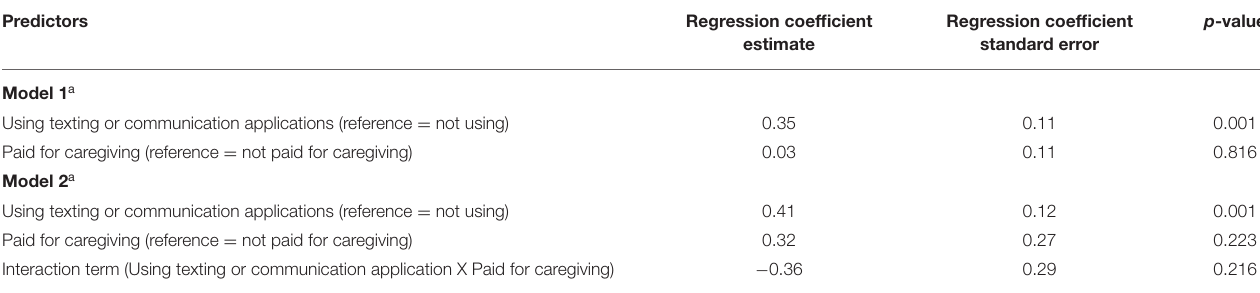
TABLE 3 | Social support availability based on caregivers’ payment status and use of communication